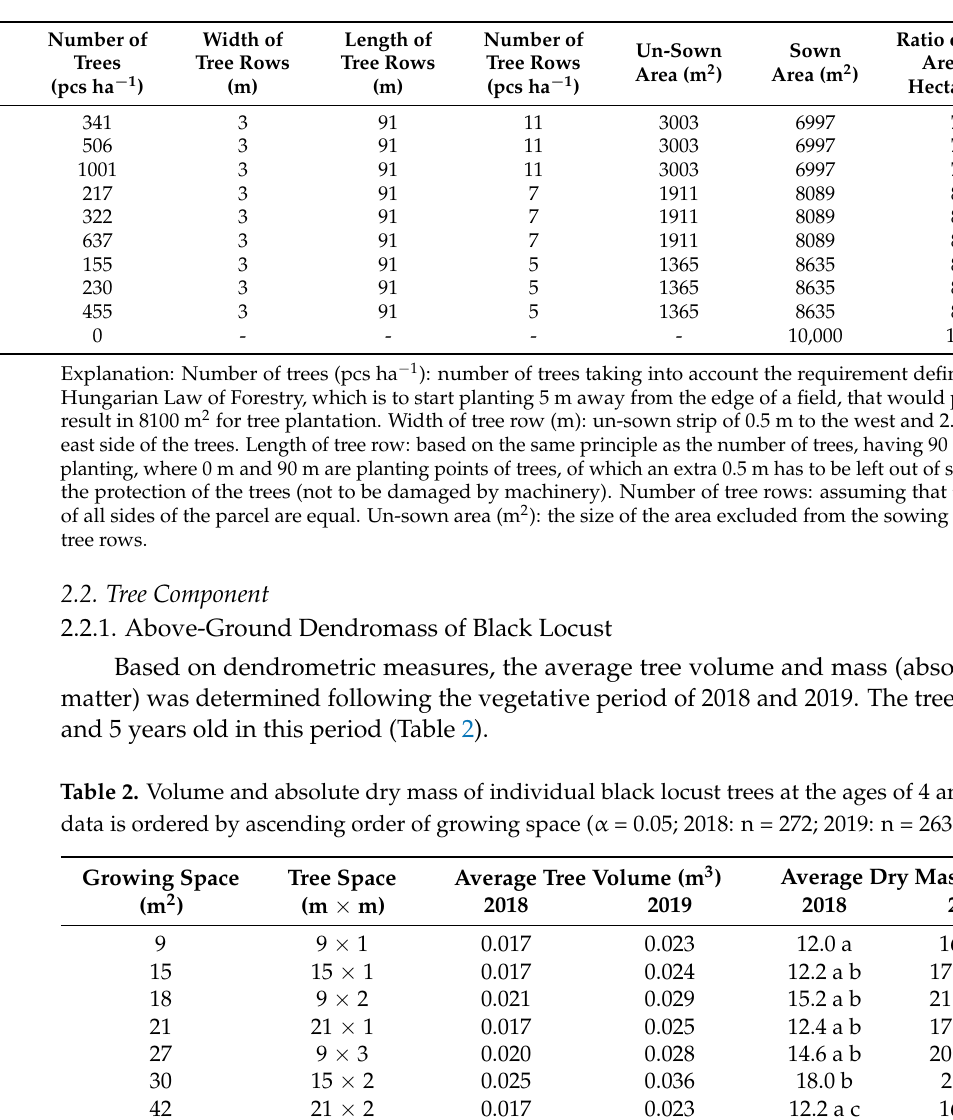
Table 1. Features defining each treatment of the alley cropping experiment based on one hectare.